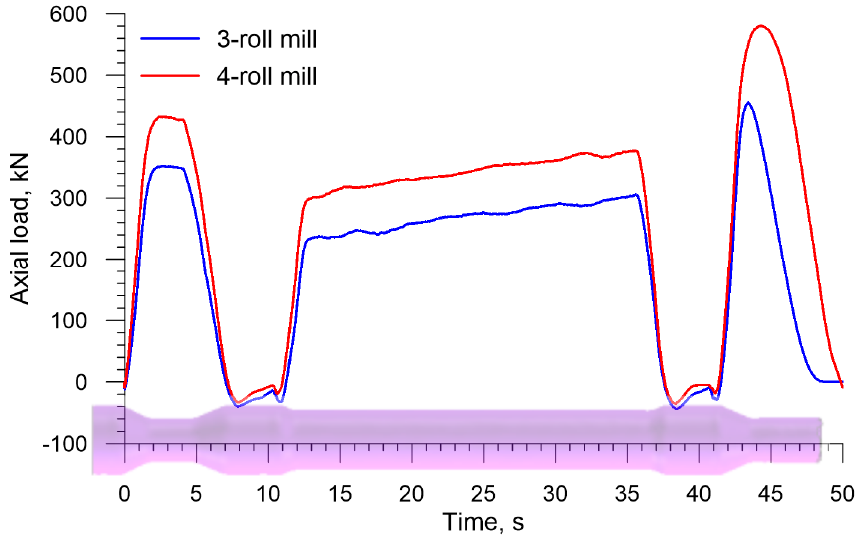
Figure 11. Axial load on the chuck in skew rolling railway axles in 3-and 4-roll mills.